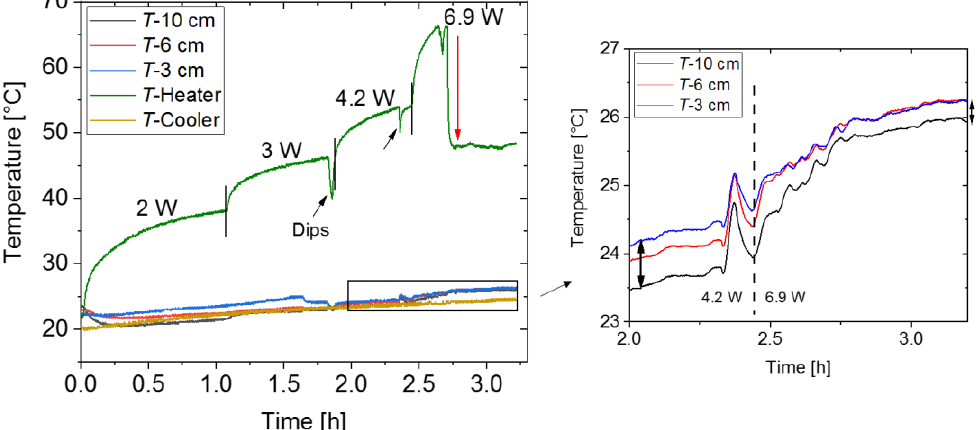
Figure 13. First sequence of temperatures measured along heat pipe vs. time for different heating powers (temperature measurement locations as defined in Figure 7). ( Left image ) All temperatures including heater and cooler temperature. Vertical black lines indicate the beginning and end of each power plateau, respectively. The red arrow indicates a significant temperature drop associated with the abrupt release of the working fluid water. ( Right image ) Inset with temperatures in adiabatic zone only.